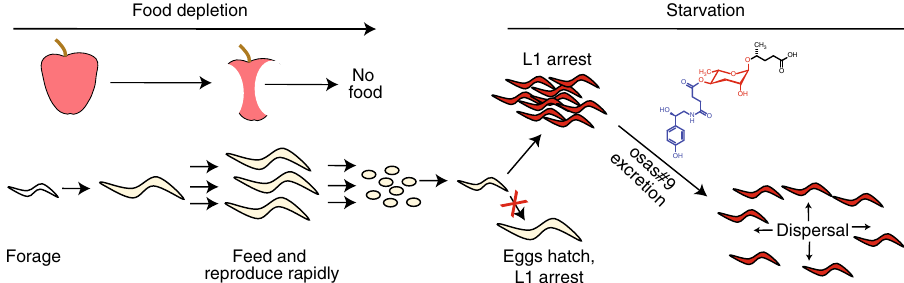
Fig. 7 osas#9 serves as a dispersal cue for C. elegans . An animal navigating its environment encounters a food source, where offspring grow and reproduce rapidly, eventually depleting their food source. Eggs hatch on the depleted food patch and halt development as L1 arrest animals. L1 arrest animals secrete the aversive compound, osas#9, signaling for conspeci fi cs to disperse away from the unfavorable condition